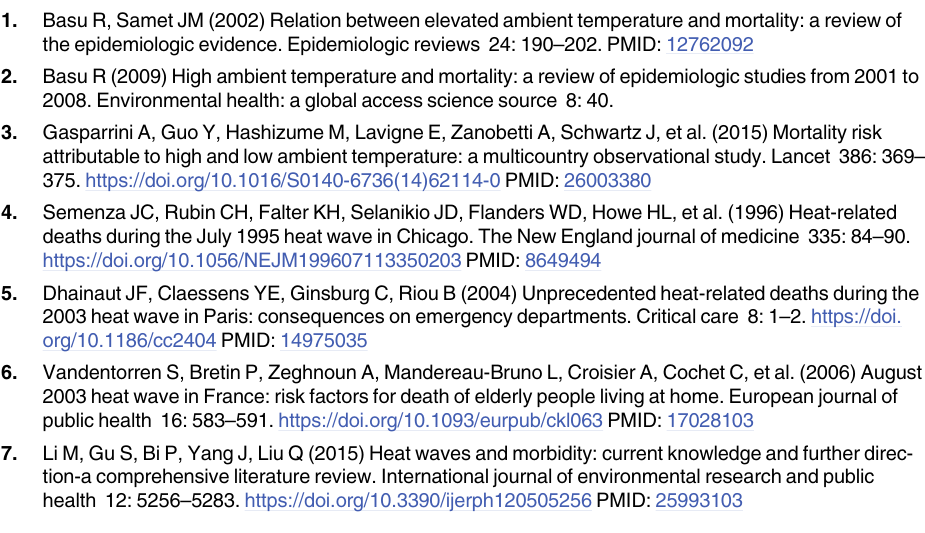
S1 Table. Deidentified dataset used for the statistical analyses.